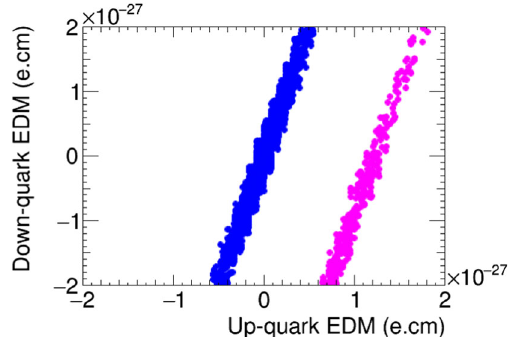
Fig. 6 Distributions of scan points in the up-quark EDM vs. down quark EDM plane, showing the effects of taking into account the LHC constraints on sparticle masses and imposing the EDM constraints. Blue: including possible future proton EDM constraint, assuming a central value of zero; magenta: including possible future proton EDM measurement of ( 1 ± 0 . 025 ) × 10 − 27 e.cm